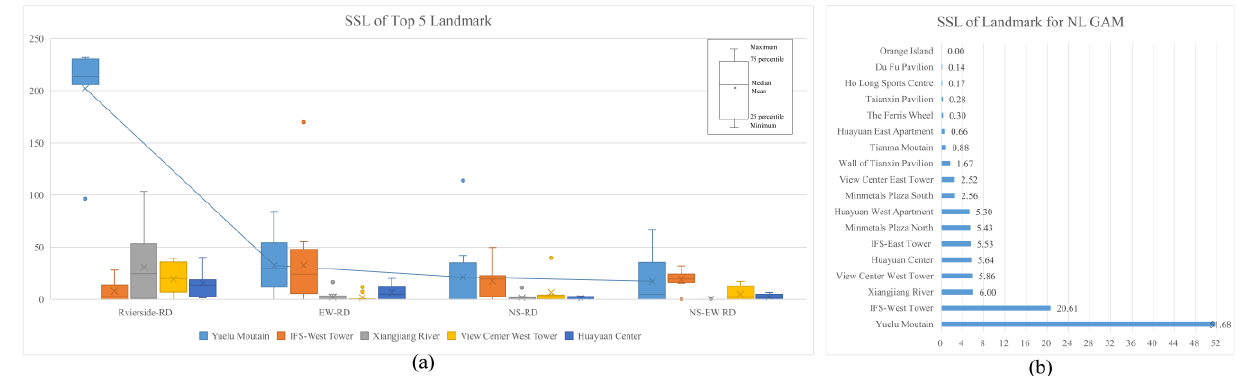
Figure 17. Structural salience of TP-district landmarks. ( a ) Boxplot of the structural salience of TOP5 landmarks corresponding to each decision point, ( b ) bar chart of the structural salience of landmarks in grid.